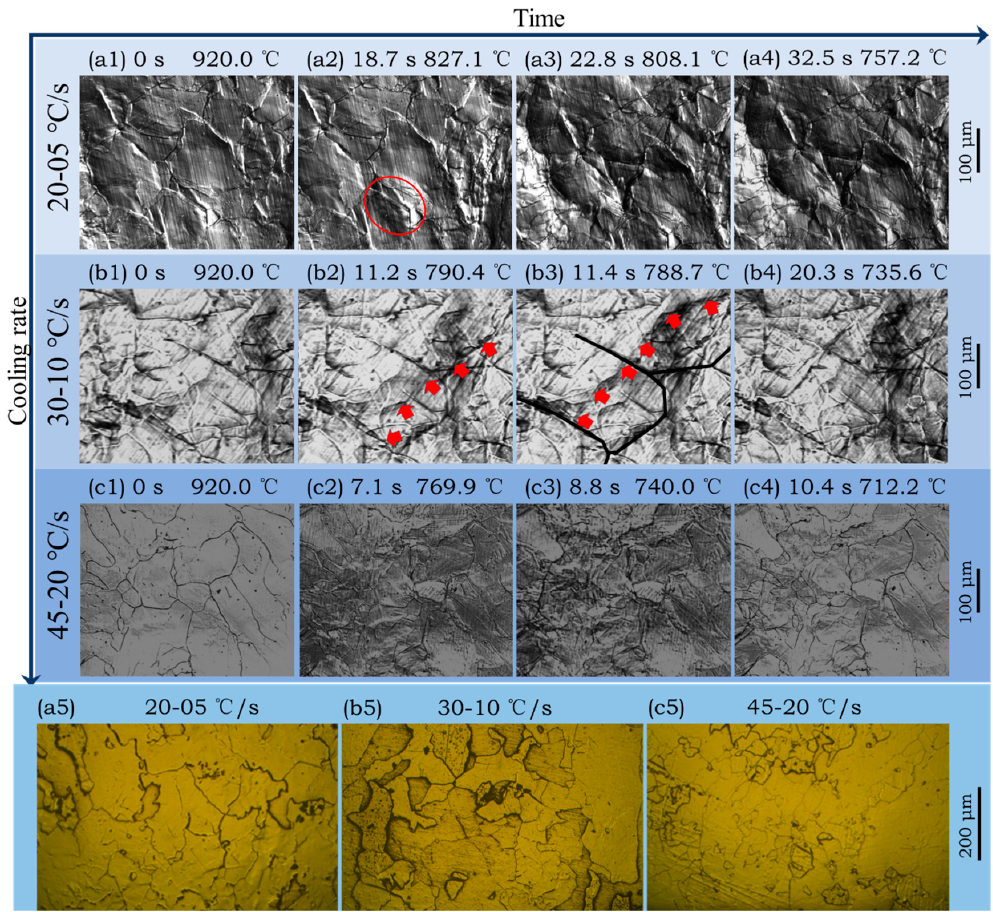
Figure 8. ( a1 – c4 ): Ferrite transformation of subrapid solidified samples at three different cooling rates and ( a5 – c5 ): corresponding optical microstructure etched by nitric acid. Circle in ( a2 ) delineates ferrite nucleation at prior austenite boundaries. Red arrows in ( b2 ) and ( b3 ) depict a route of γ / α interface migration. Black curves in ( b2 ) and ( b3 ) outline prior γ boundaries. Due to the ultralow content of carbon, long-range diffusion is not necessary at γ / α interface during the ferrite transformation. The phase transformation belongs to interface- controlled type. Thermally activated atoms cross the γ / α interface and rearrange as ferrite quickly. The arrows in Figure 8 b2,b3 indicate the position and growth direction of α grains. The growth rate was about 350 mm/s on average. Some α grains grew across prior γ grains, indicating that the γ / α interface was incoherent. Figure 8 a5–c5 show the optical microstructures of the above three samples after coiling at 700 °C. They all have ragged ferrite grains with irregular boundaries. All of these features match well with massive transformation [28,36].